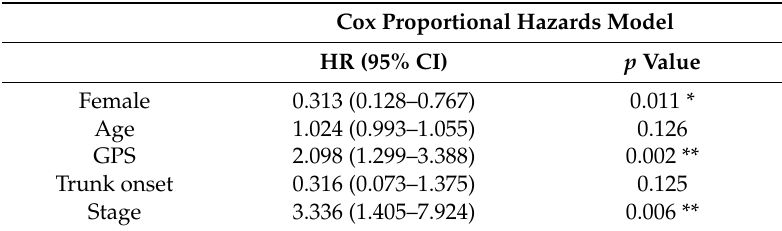
Table 6. Risk factors for poor prognosis of STS patients with resection